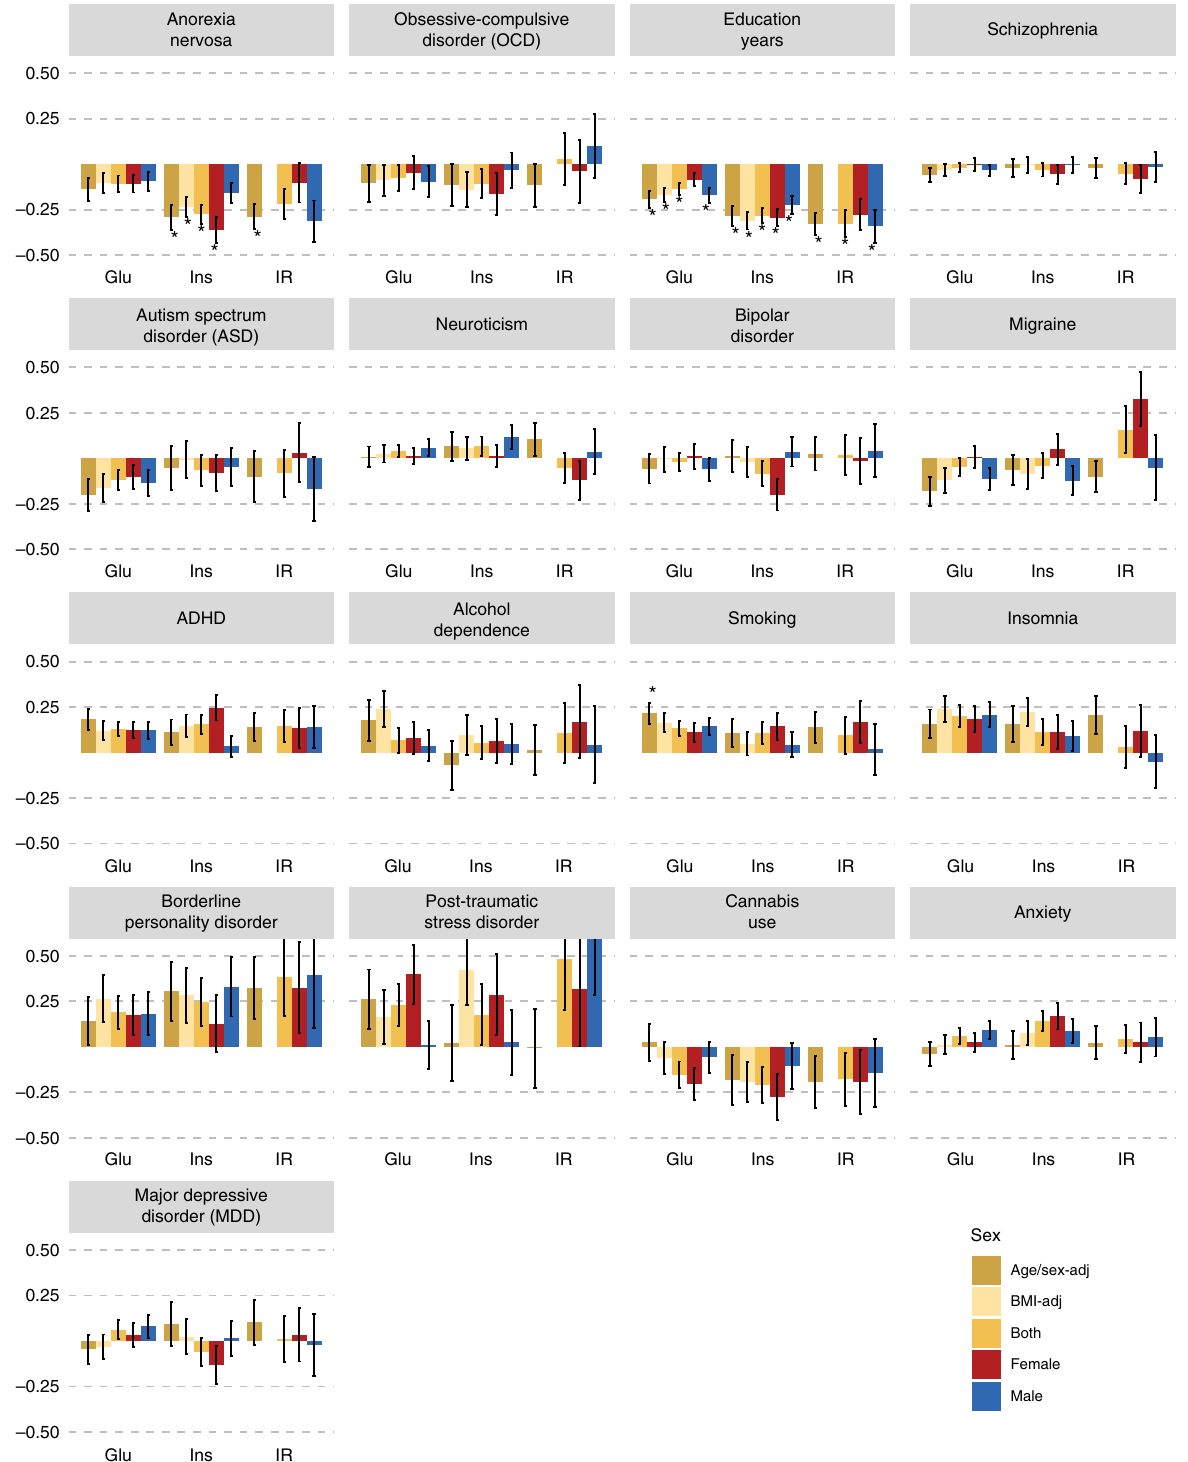
Fig. 3 Sex-speci fi c genetic correlations across glycaemic traits and psychiatric traits. Sex-speci fi c genetic correlations of glycaemic traits ( n = up to 140,583) with sex-combined psychiatric disorders ( n = up to 77,096) and behavioural traits ( n = up to 157,355). The autosomal genetic correlations were calculated by bivariate linkage disequilibrium score regression (LDSC). Coloured bars represent genetic correlations, error bars depict standard errors (s.e.) and asterisks indicate statistically signi fi cant genetic correlations with p values less than α = 0.0002. This threshold was calculated via the identi fi cation of the number of independent tests using matrix decomposition of the genetic correlation matrix and subsequent Bonferroni correction of α = 0.05 for 231 independent tests. ADHD = attention-de fi cit/hyperactivity disorder, Glu = fasting glucose, Ins = fasting insulin, IR = insulin resistance, adj =